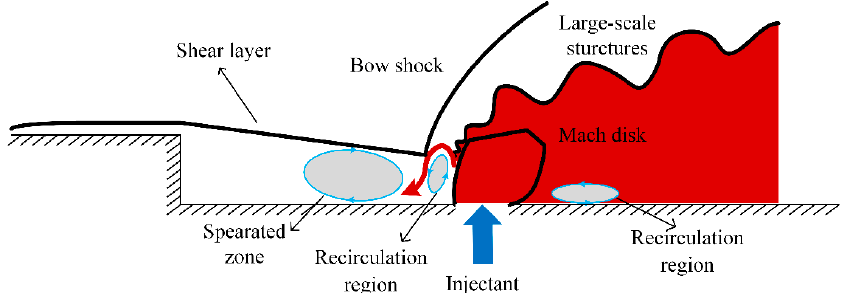
Figure 13. Schematics of the transverse injection of an under-expanded jet into a supersonic crossflow with the effect of the BFS.